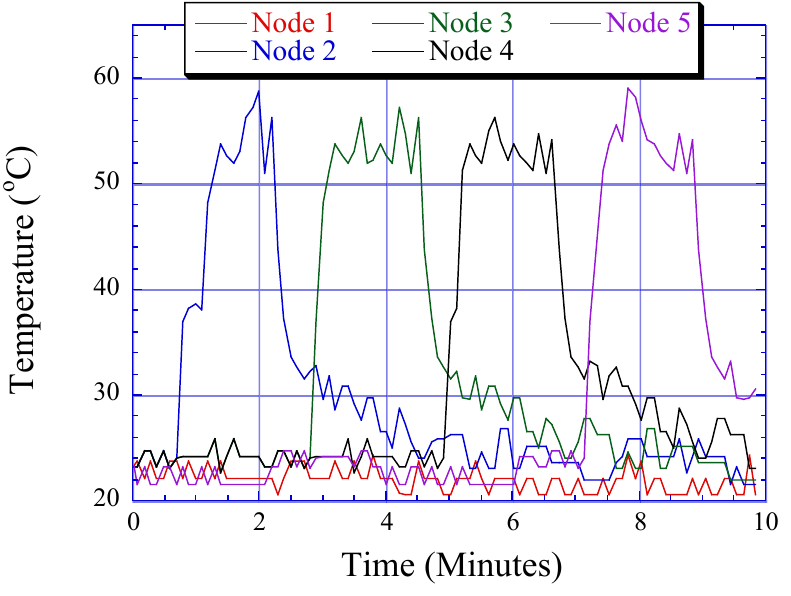
Figure 14. The measured temperature of the sensor nodes. Node 2, 3, 4, and 5 were sequentially heated while the temperature on Node 1 was